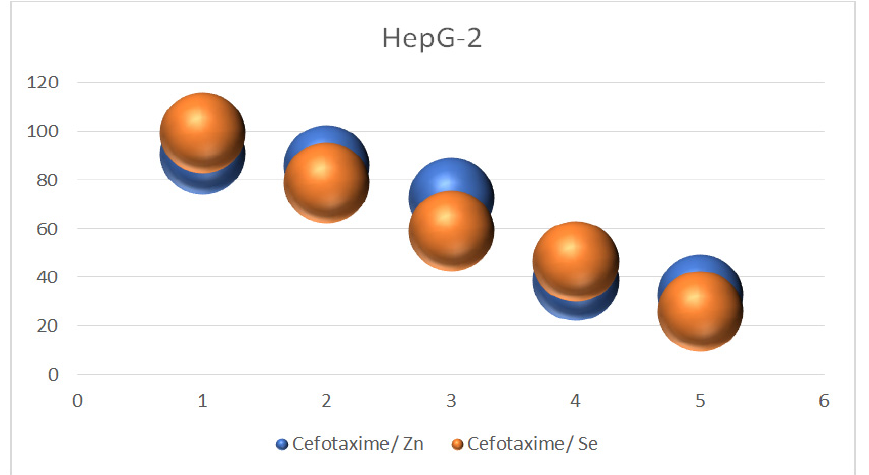
Table 7. Dilution concentration (mg/mL sample) and bacterial inhibition concentration of cefo- Figure 11. Anticancer activity of cefotaxime/Zn and cefotaxime/Se. taxime and its metal complexes (three replicates).